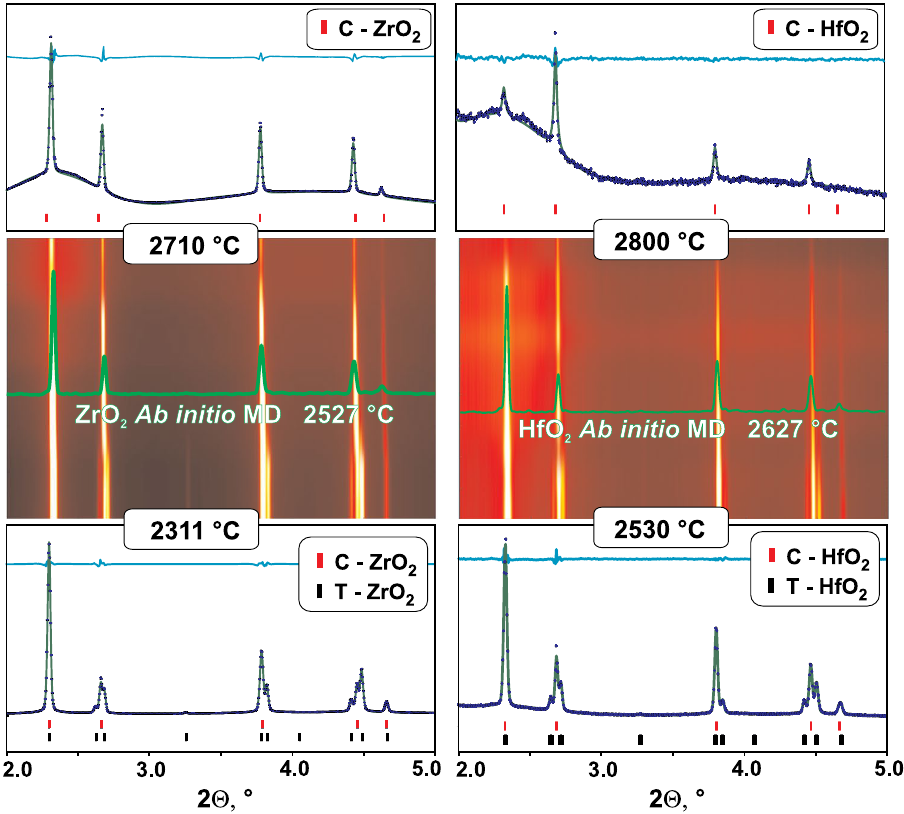
Figure 2. Center: contour plots of X-ray diffraction (XRD) patterns ( λ = 0.12359 Å) with cubic ZrO 2 and HfO 2 from tetragonal-to-cubic transition to melting onset. The patterns obtained from ab initio MD simulations are included for comparison. Top and bottom: Pawley refinements of XRD patterns of cubic ZrO 2 and HfO 2 in the presence of melt and tetragonal phase (experimental data points, modeled pattern and difference curve). See Supplementary Information for refinement results for all patterns depicted in contour plots.